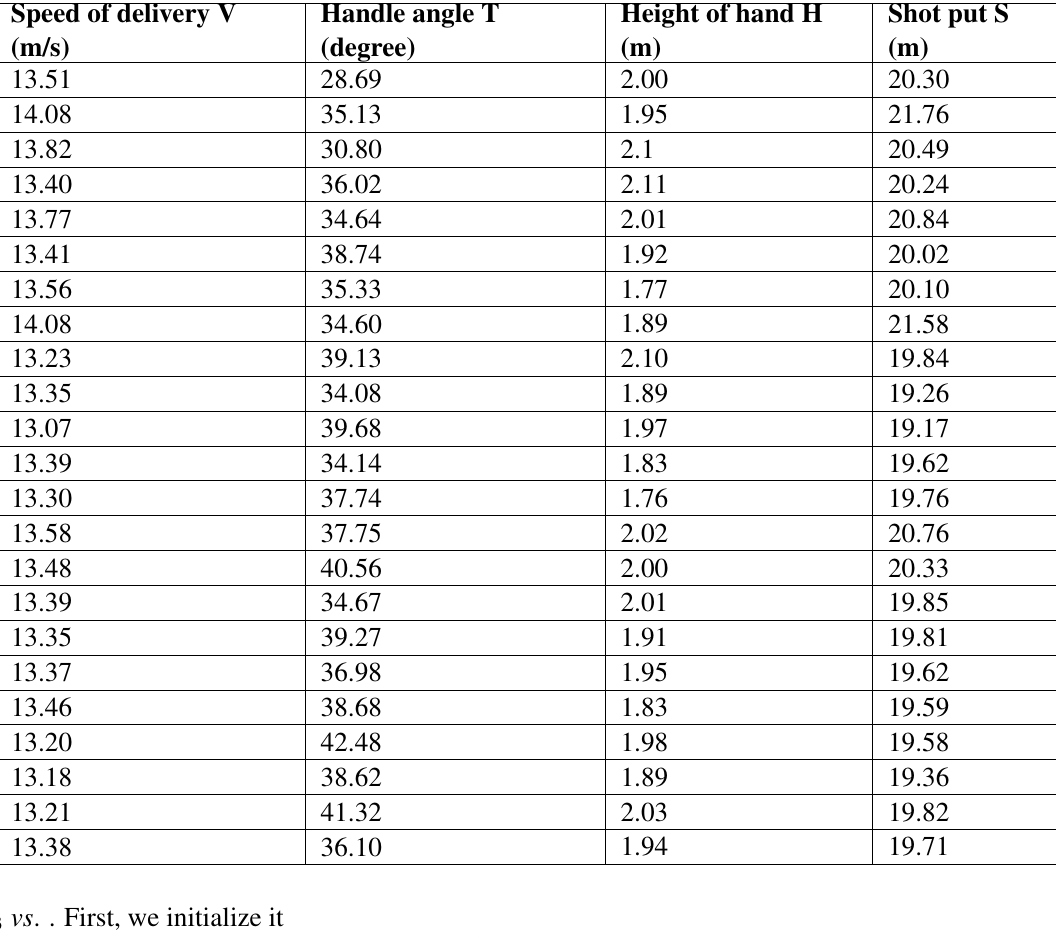
Table 1 Shot put data of an elite athlete in